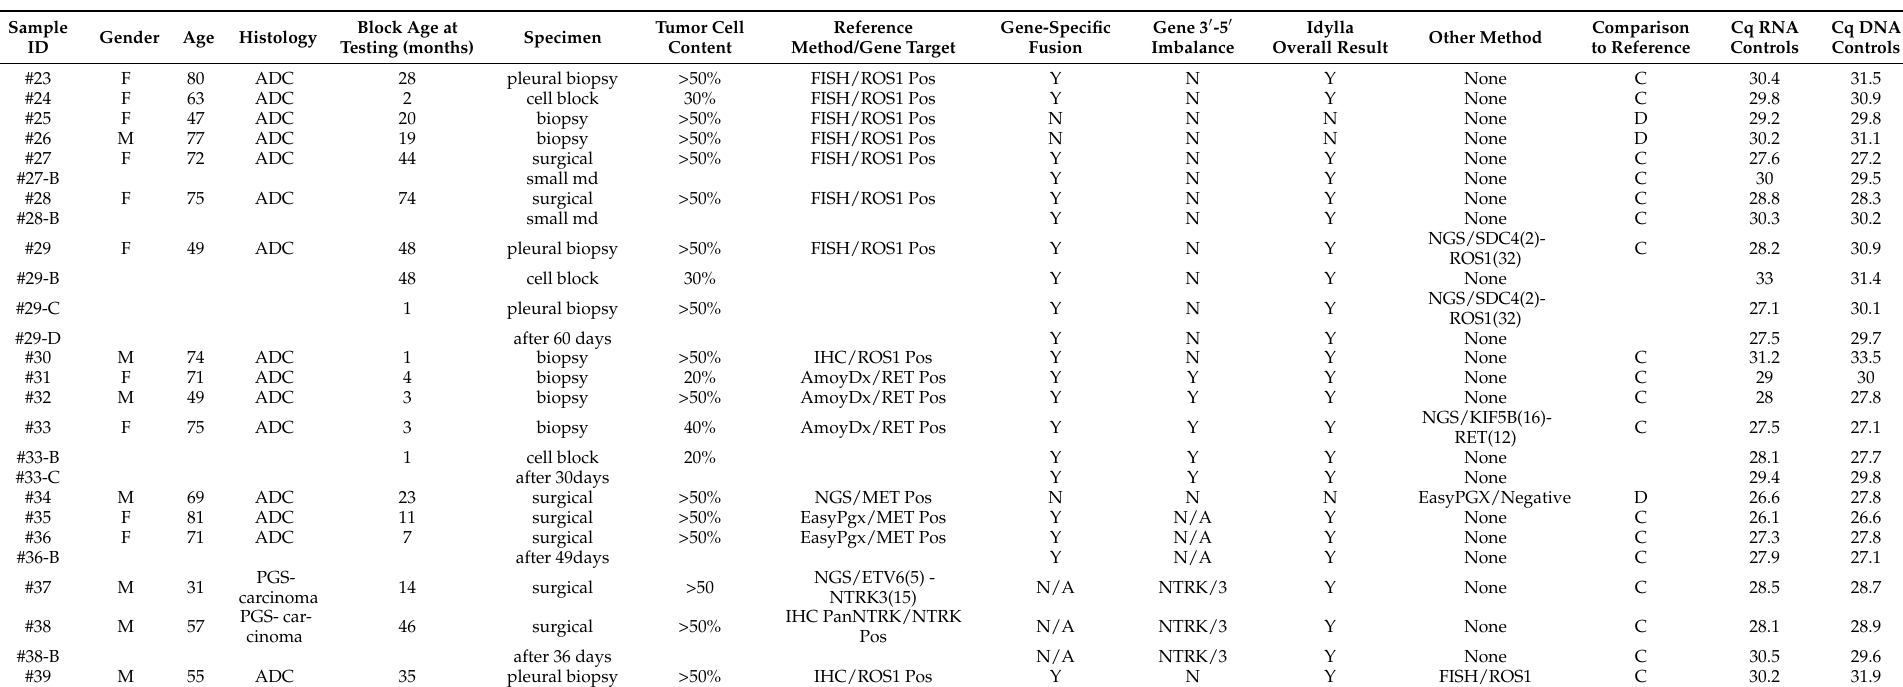
Table 2. Patient characteristics and Idylla GeneFusion performance versus reference method for ROS1/RET/MET/NTRK